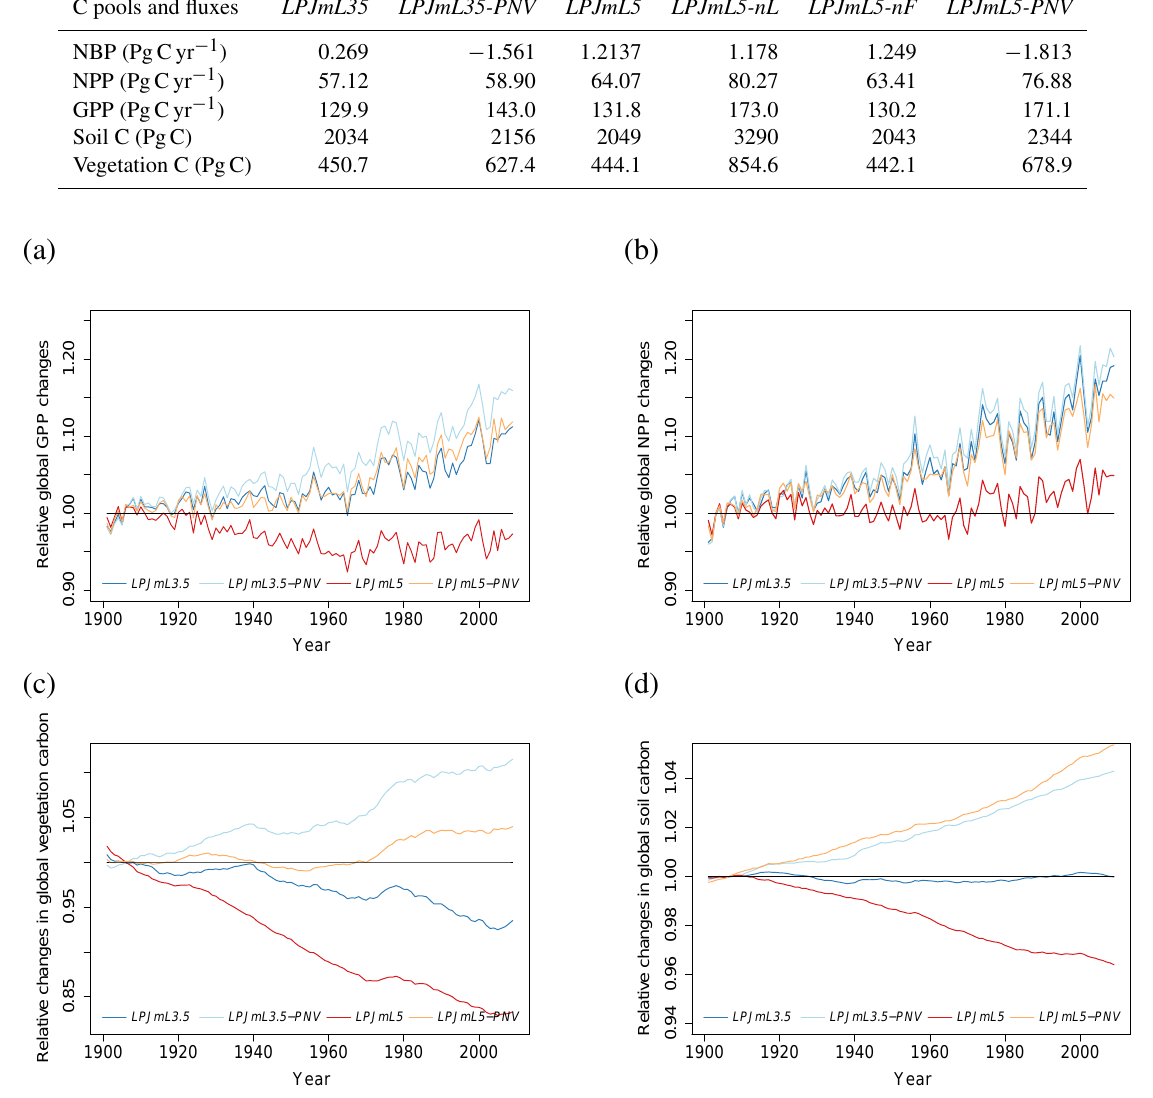
Figure 4. Relative global changes in GPP (a) , NPP (b) , vegetation carbon (c) , and soil carbon (d) . Relative changes are calculated by dividing the values by their 1901–1910 average to make the different model versions and settings comparable. The blue lines denote values for LPJmL3.5 with land use ( LPJmL3.5 ), the light blue lines for LPJmL3.5 with natural vegetation only ( LPJmL3.5-PNV ), the red lines for LPJmL5.0 with land use ( LPJML5 ), and the orange lines for LPJmL5.0 with natural vegetation only ( LPJmL5-PNV